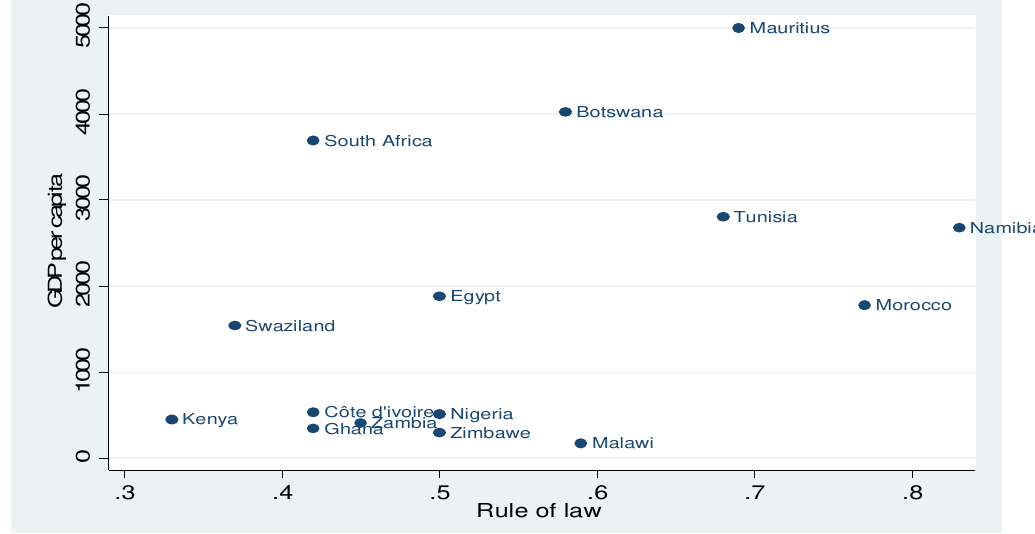
Fig. 3. Relationship between GDP per capita and rule of law for 2009 Source: authors’ computation.